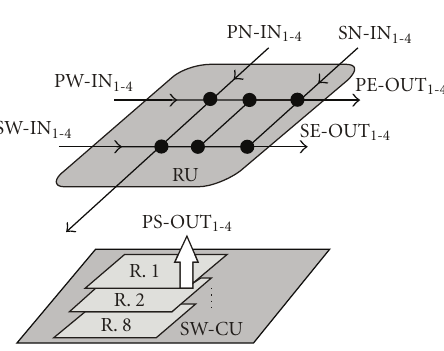
Figure 17: Dataflow between the SW-CU and RU building blocks inside the